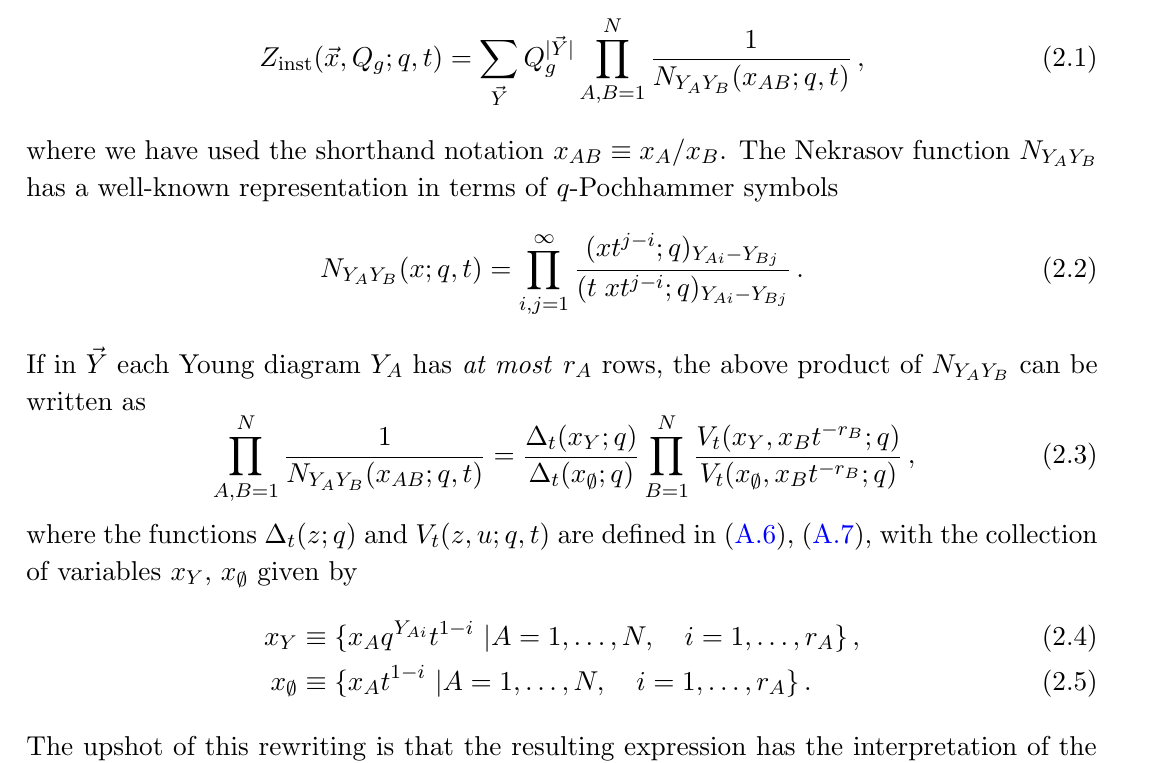
Figure 2 . A cartoon of ( C complex planes C q , C can be represented by the toric diagram of the T 3 action shown on the right. The T 3 action reduces to T 2 on the two edges corresponding to the subspaces C q the rotation of the S 1 at the vertex corresponding to the intersection S 1